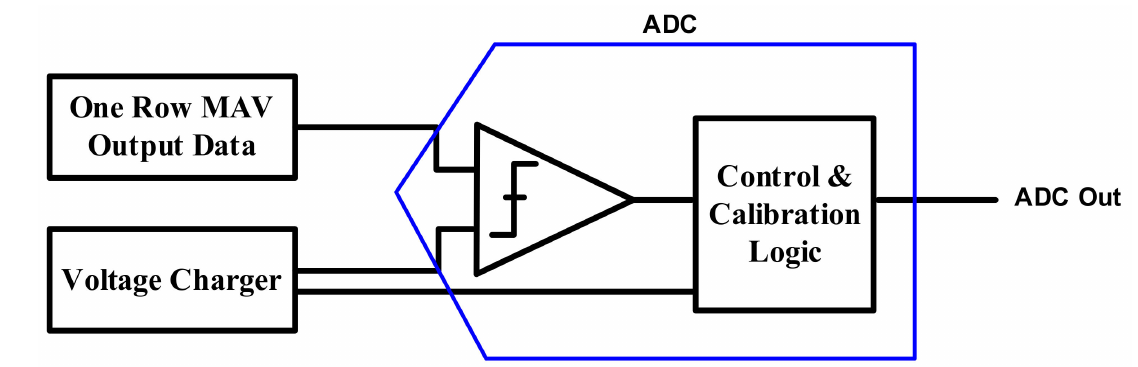
Figure 7. The proposed ADC architecture of analog PIM with calibration.